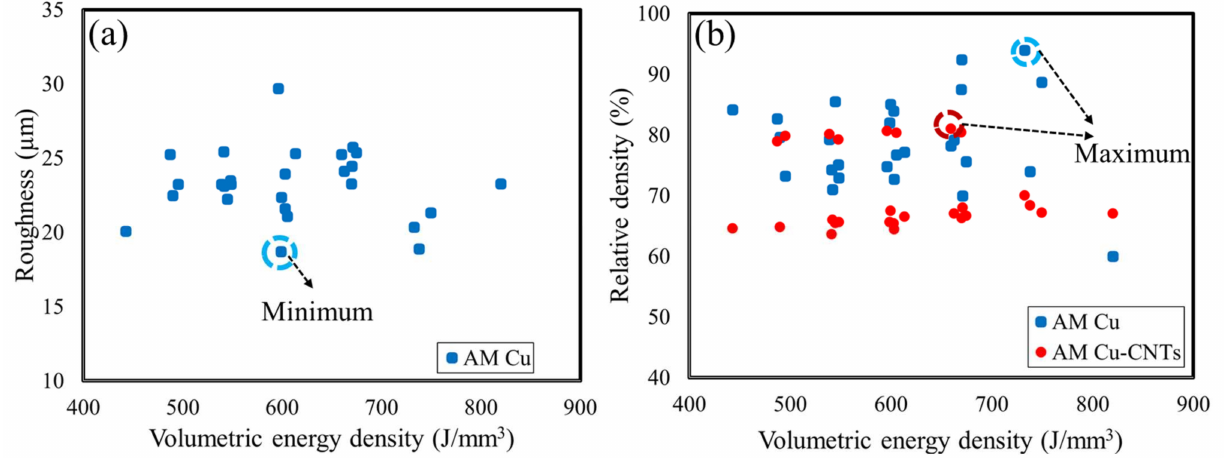
Figure 5. ( a ) Average surface roughness and ( b ) relative density as a function of volumetric energy density for AM Cu and